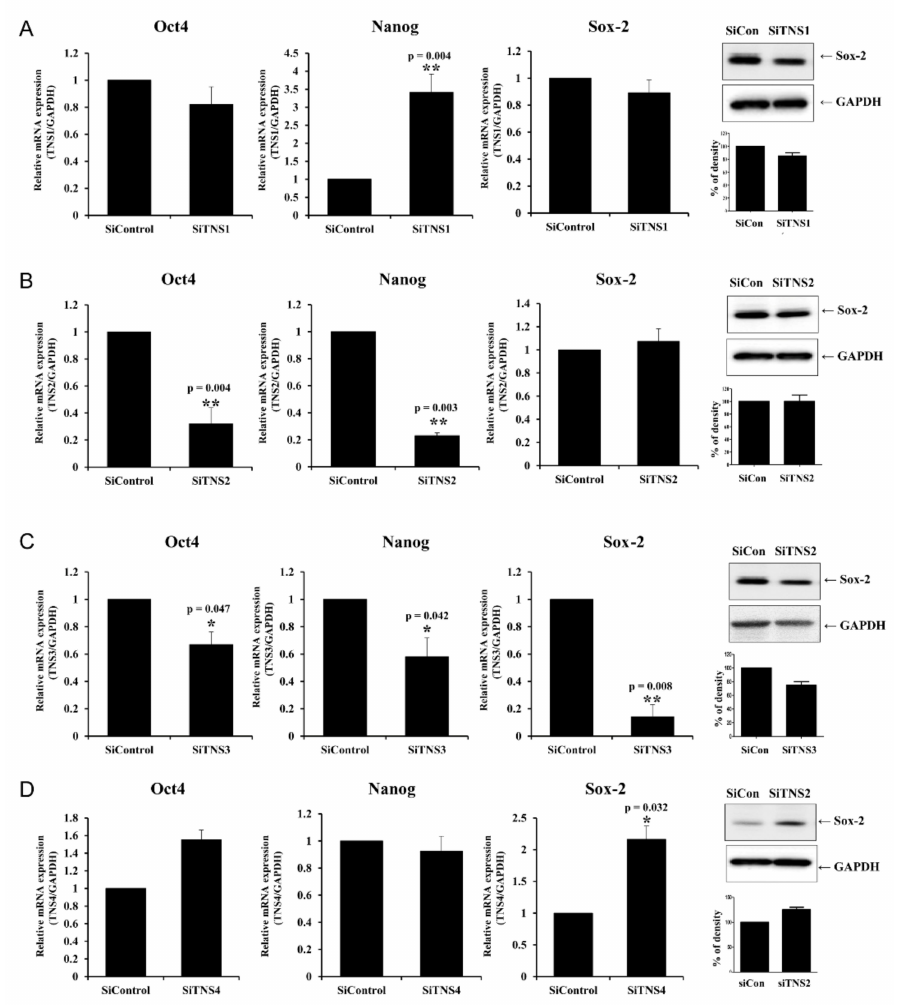
Figure 4. Tensin also influenced the pluripotency of tonsil mesenchymal stem cells. The graph depicts the changes in Oct4, Nanog, and Sox-2 after treatment with siTNS1 ( A ), siTNS2 ( B ), siTNS3 ( C ), and siTNS4 ( D ). Oct4 and Nanog were significantly decreased upon siTNS2 and siTNS3 treatment. siTNS3 and SiTNS4 treatment decreased and increased Sox-2 levels, respectively. * p < 0.05 and ** p < 0.01, compared to siControl. n = 4. Columns and error bars represent mean ± standard